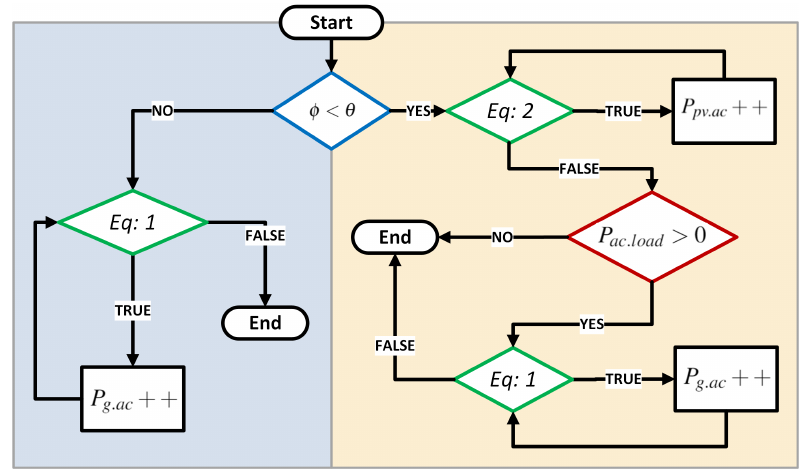
Figure 9. Case IV flow chart.